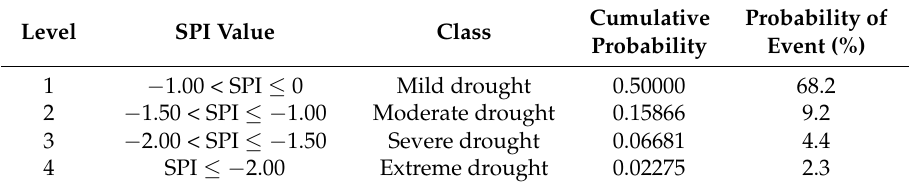
Table 3. Standardized Precipitation Index classification